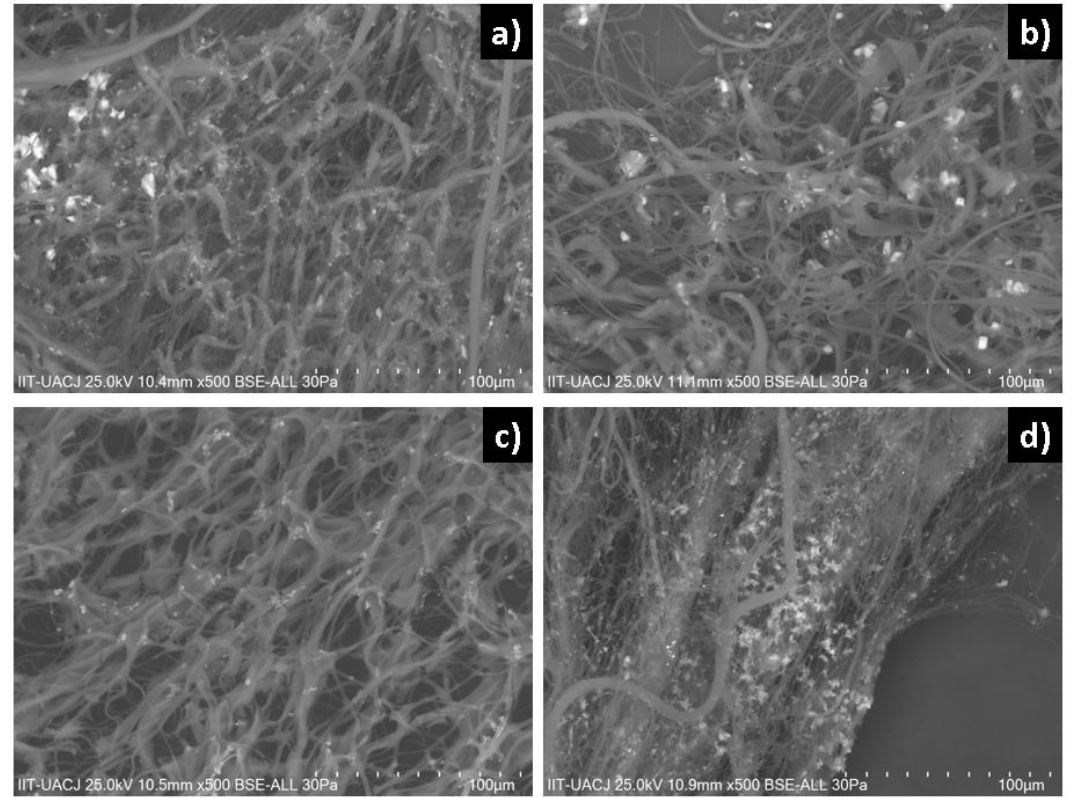
Figure 11. Morphology of mineralization of the fibers: ( a ) PCL, ( b ) PCL-HA, ( c ) PCL- α -Al 2 O 3 , and ( d ) PCL-HA- α -Al 2 O 3 .